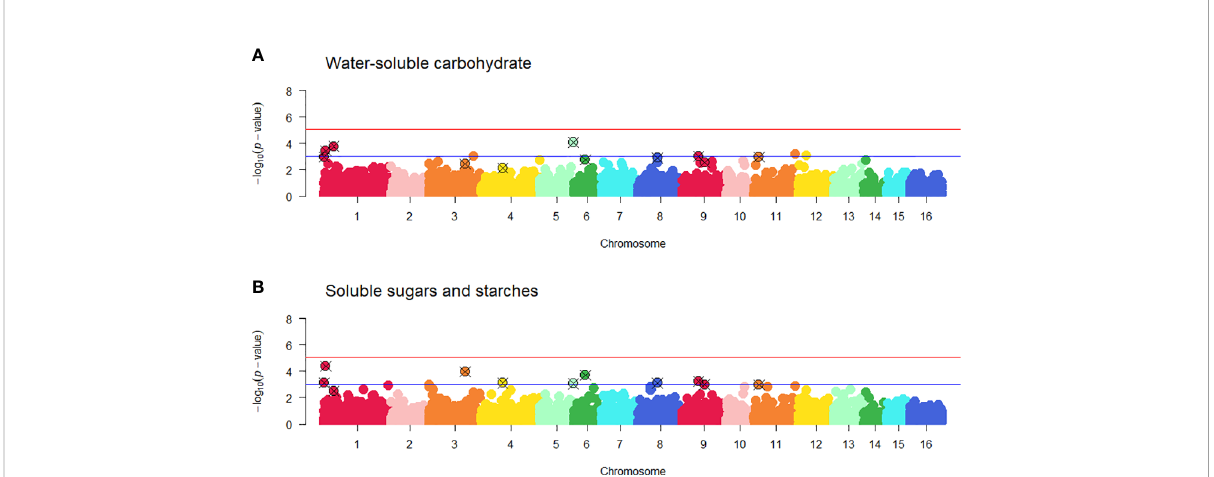
FIGURE 6 Manhattan plots from the genome-wide association study (GWAS) of water-soluble carbohydrate, WSC-NIRS (A) and soluble sugars and starch, SSS (B) using 5,757 SNP markers and 605 individuals. -log 10 ( p -values) are plotted against physical map position of SNPs with subgenomes of corresponding chromosomes (i.e., pseudomolecules) similarly coloured (Tr To 1 – 8 and Tr Tp 9 – 16). Signi fi cant loci lie above the false discovery rate thresholds as denoted by the red ( a = 0.01) and blue (-log 10 ( p -value) > 3) solid lines. Twelve SNPs with -log 10 ( p -values) > 3 identi fi ed for the WSC-NIRS and SSS traits are highlighted. Quantile-Quantile plots for each trait are presented in Supplementary Figure